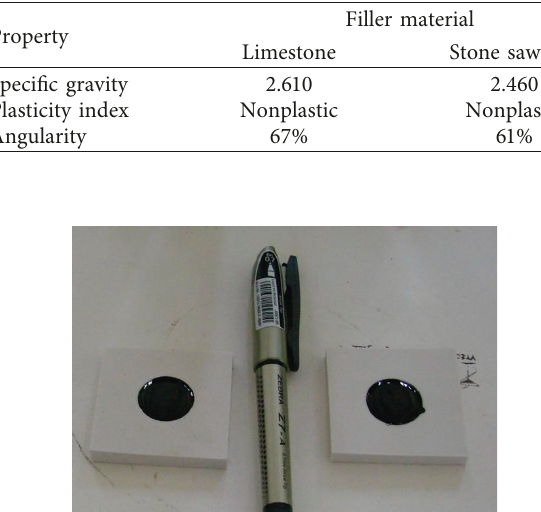
Table 2: Properties of fillers used in the study.